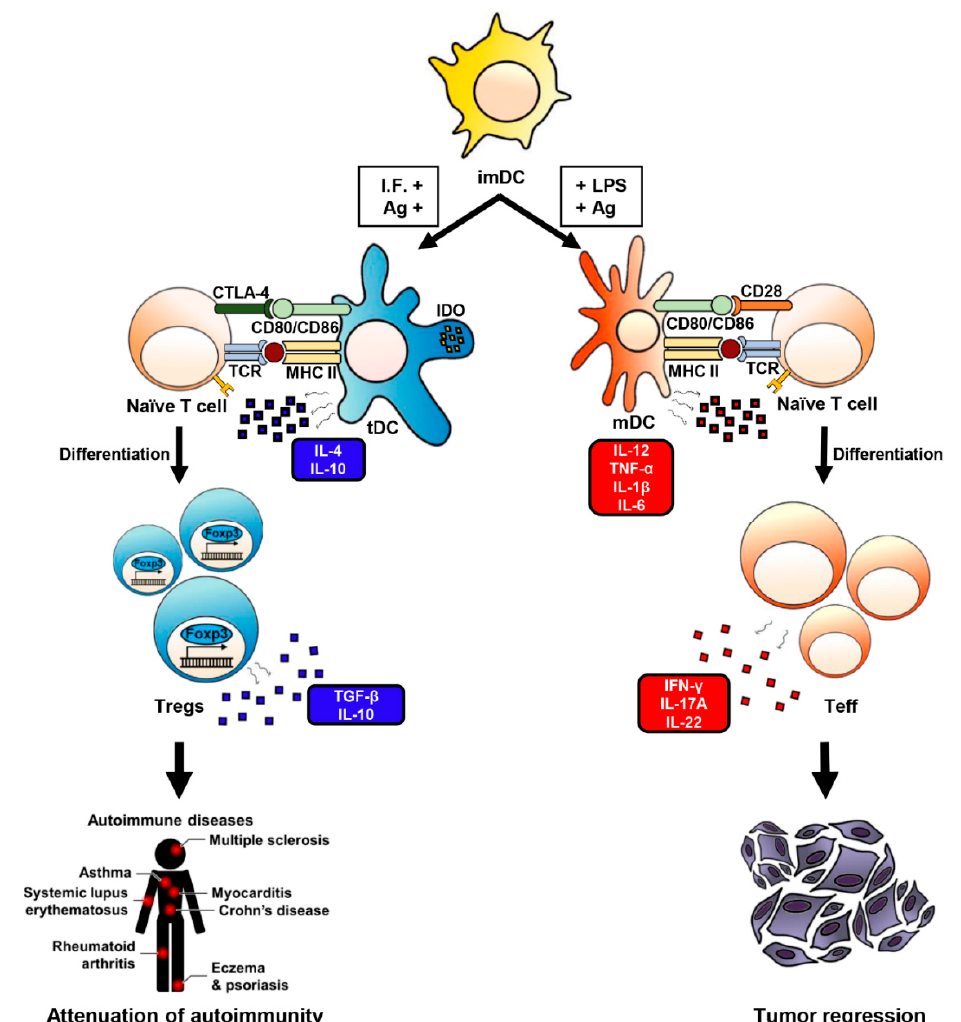
Figure 1. Functional overview of DCs. Generation and therapeutic effects of Treg cells and T helper cells. Abbreviations: imDC (immature DC); I.F. (immunosuppressive factor); Ag (antigen); LPS (lipopolysaccharide); NF- κ B (nuclear factor kappa-light-chain-enhancer of activated B cells); PPAR- γ (peroxisome proliferator-activated receptor gamma); tDC (tolerogenic DC); mDC (fully-matured DC); IDO (indoleamine 2,3-dioxygenase); CTLA-4 (cytotoxic T-lymphocyte-associated protein 4); MHC II (major histocompatibility complex class II); TCR (T-cell receptor); Treg (T regulatory cell); Teff (effector T cell); Foxp3 (forkhead box P3); TGF- β (tumor growth factor- β